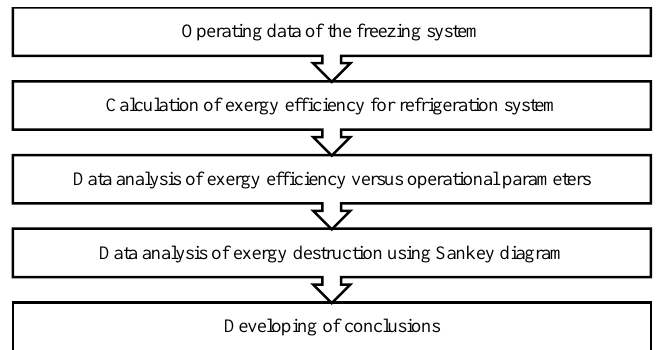
Fig. 1. Algorithm of exergy efficiency analysis for refrigeration